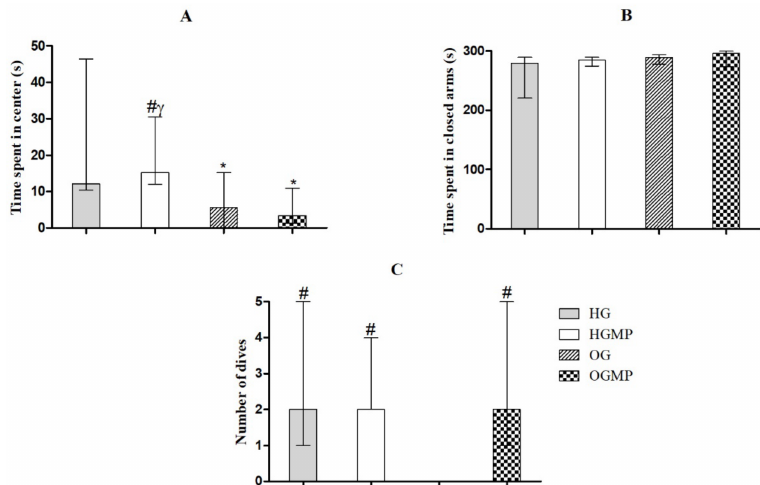
Figure 2. Results of the elevated plus-maze test regarding the time spent in the center of the apparatus ( A ), time spent in the closed arm ( B ) and number of dives ( C ) of healthy and obese rats treated or not with MP seed extract. Data presented as median (minimum and maximum). Kruskal-Wallis test, Dunn post-hoc ( p ≤ 0.05). * di ff ered from HG; # di ff ered from OG.; γ di ff ered from